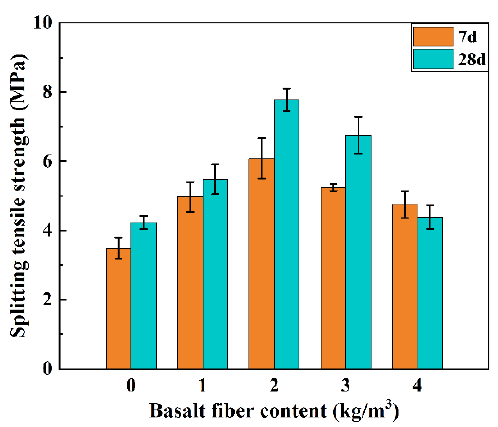
Figure 9. Splitting tensile strength.